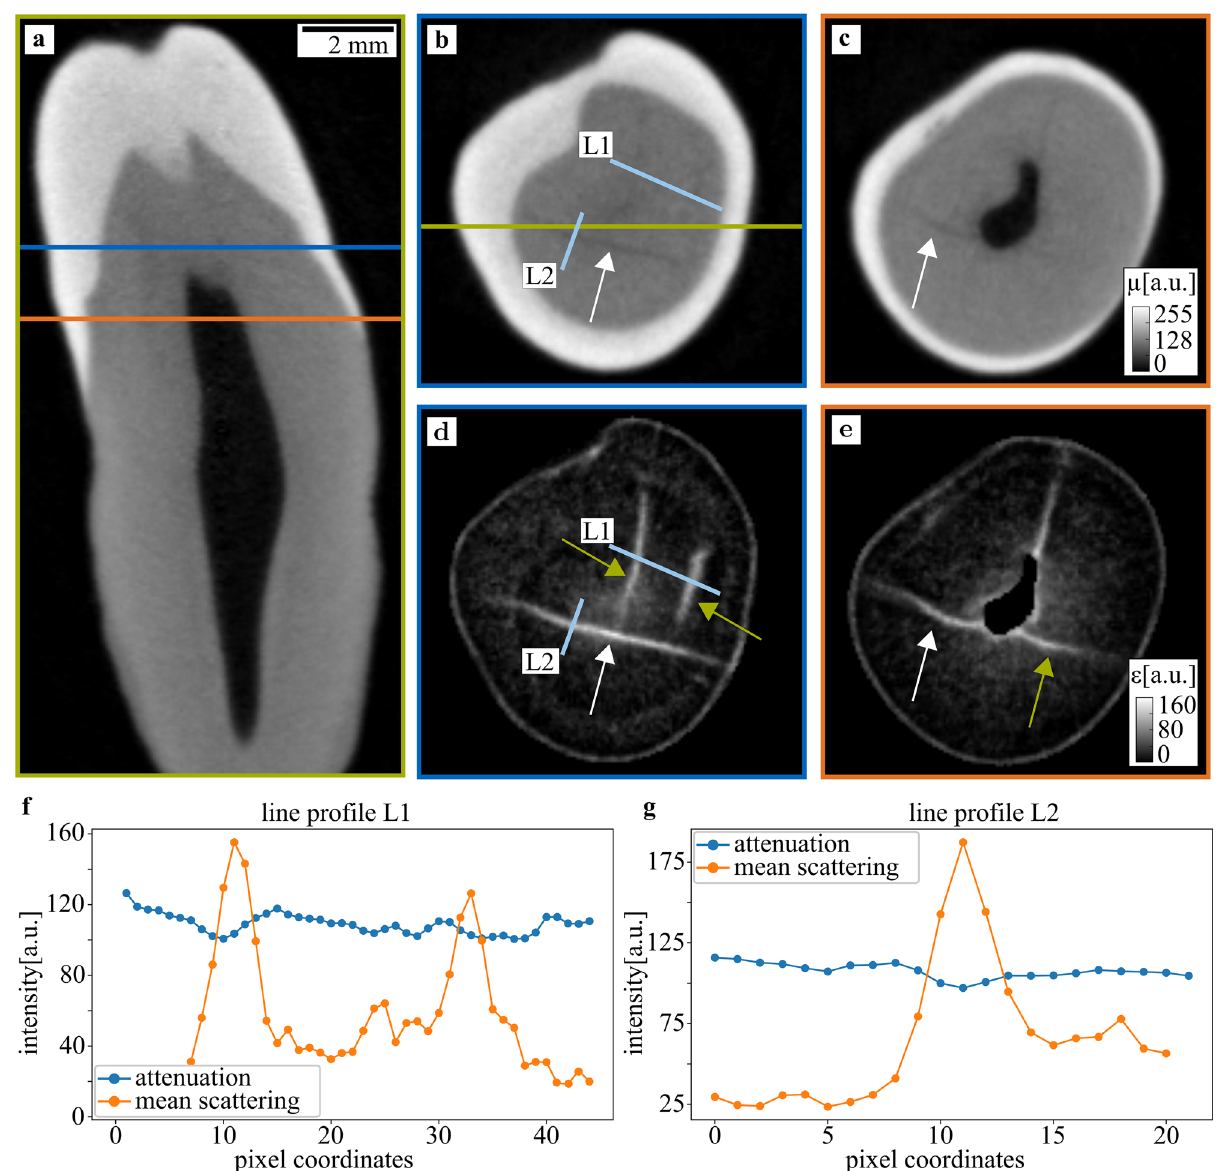
Figure 2. Attenuation and mean scattering tomographic images of a molar tooth. In ( a ), a sagittal slice through the reconstruction depicts enamel, dentin, and pulp, which are also visible in the axial slices in ( b ) and ( c ). The dentin region is homogeneous, a crack is indicated by a white arrow. Additionally, an inlet shows the line-plot L3 with the attenuation (blue) and scattering strength (orange). The corresponding scattering signal is illustrated in ( d ) and ( e ) and shows the same crack (white arrow) as well as additional ones indicated by green arrows. Two line-plots L1 and L2 highlight the difference between both contrast modalities. The slice positions are indicated by colored lines, a scale bar indicates the approximate sample